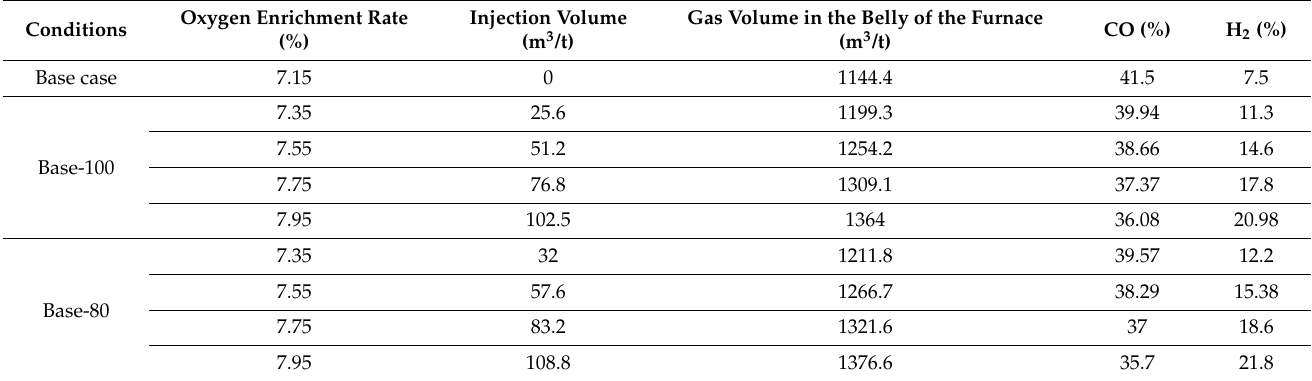
Table 7. Influence of acceptable quantities of NG on the volume and composition of bosh gas under different oxygen enrichment rates.